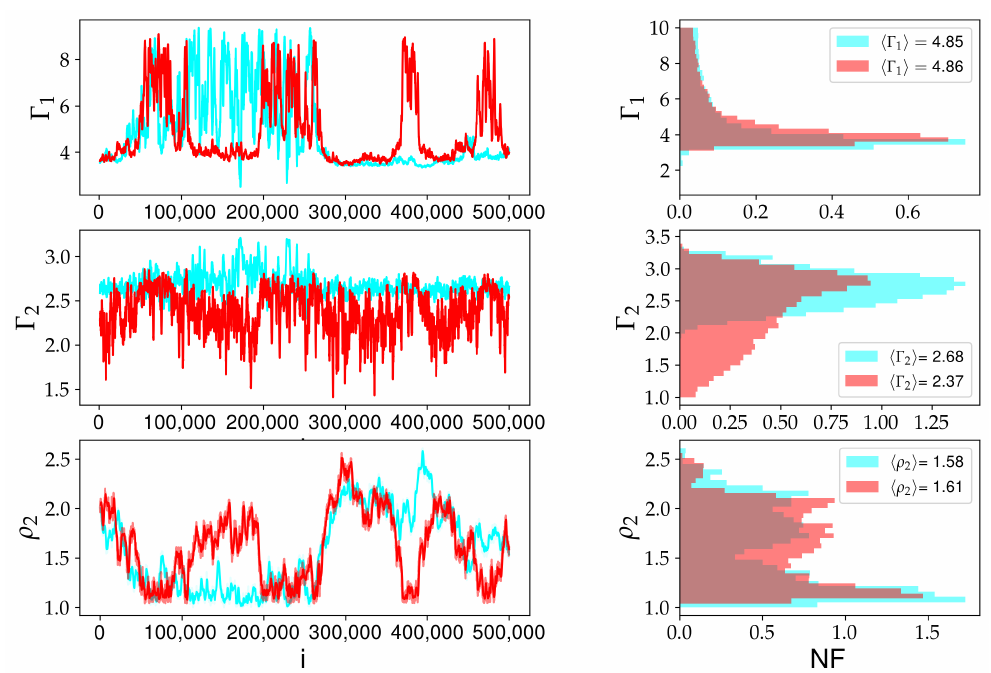
Figure 6. Analysis considering ρ 2 as a free parameter together with Γ 1 and Γ 2 . Cyan and red curves show the first transition at ρ 1 = 0.5 ρ 0 and ρ 1 = 2 ρ 0 , respectively. The intermittent behavior of the series represents “unstable” solutions of the minimization problem, more observational data points are needed here to reduce the variability of the